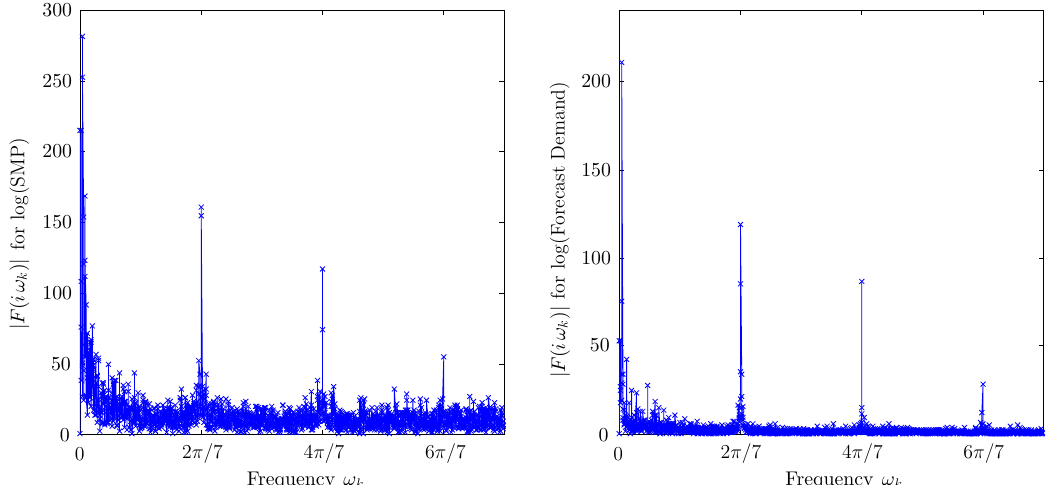
Figure 9. Periodogram plots for the log of the SMP and the log of the forecast demand time series.